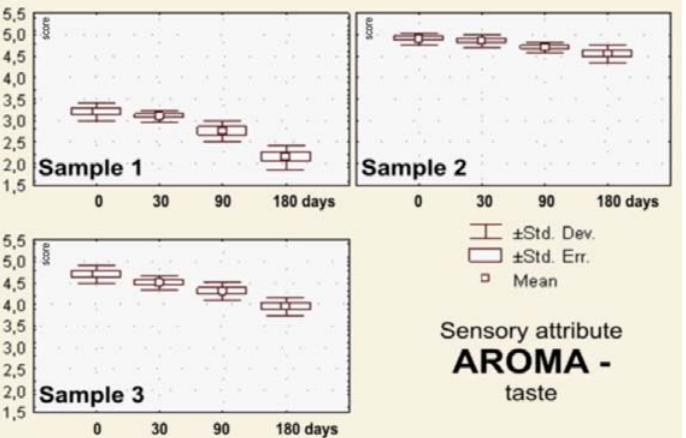
Figure 6. Box plots for sensory attribute aroma— taste of the filled pralines (labels as in the Figure 2), during 180 days of